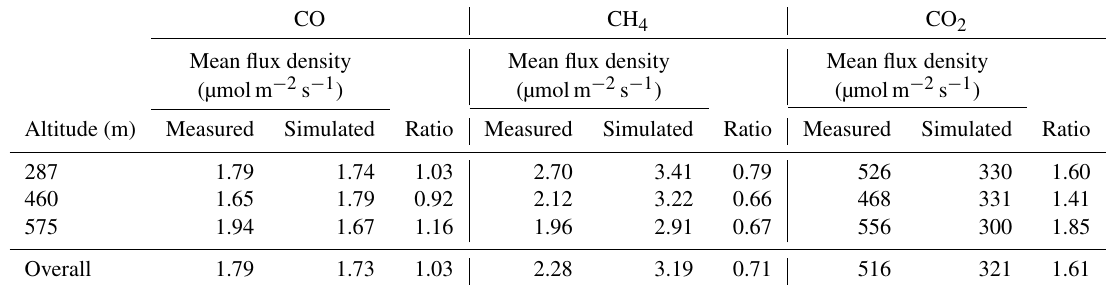
Table 2. Mean flux densities calculated using the flux-dispersion method, given for each transect and taken over all three transects. The ratios between measured and simulated flux densities are all given. CO CH 4 CO 2 Mean flux density Mean flux density Mean flux density (µmolm − 2 s − 1 ) (µmolm − 2 s − 1 ) (µmolm − 2 s − 1 ) Altitude (m) Measured Simulated Ratio Measured Simulated Ratio Measured Simulated Ratio